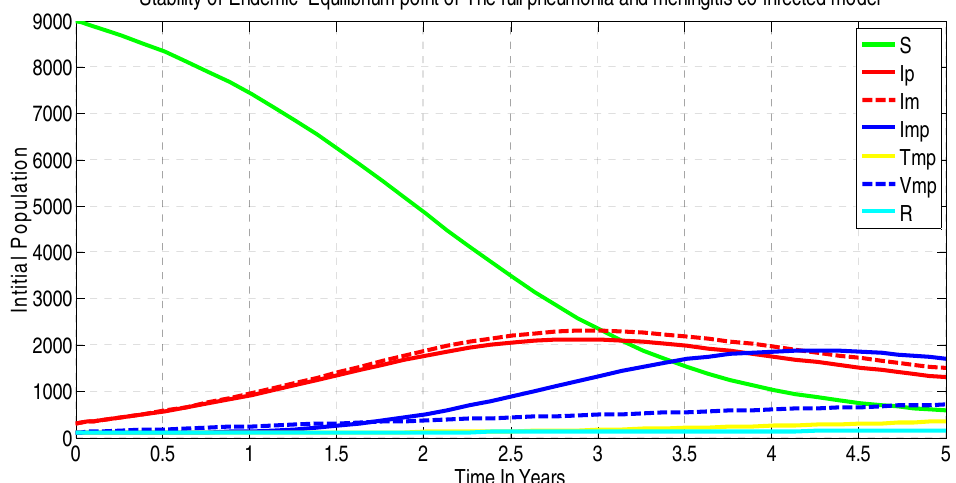
Figure 5. Stability of endemic equilibrium point of the meningitis and pneumonia confected